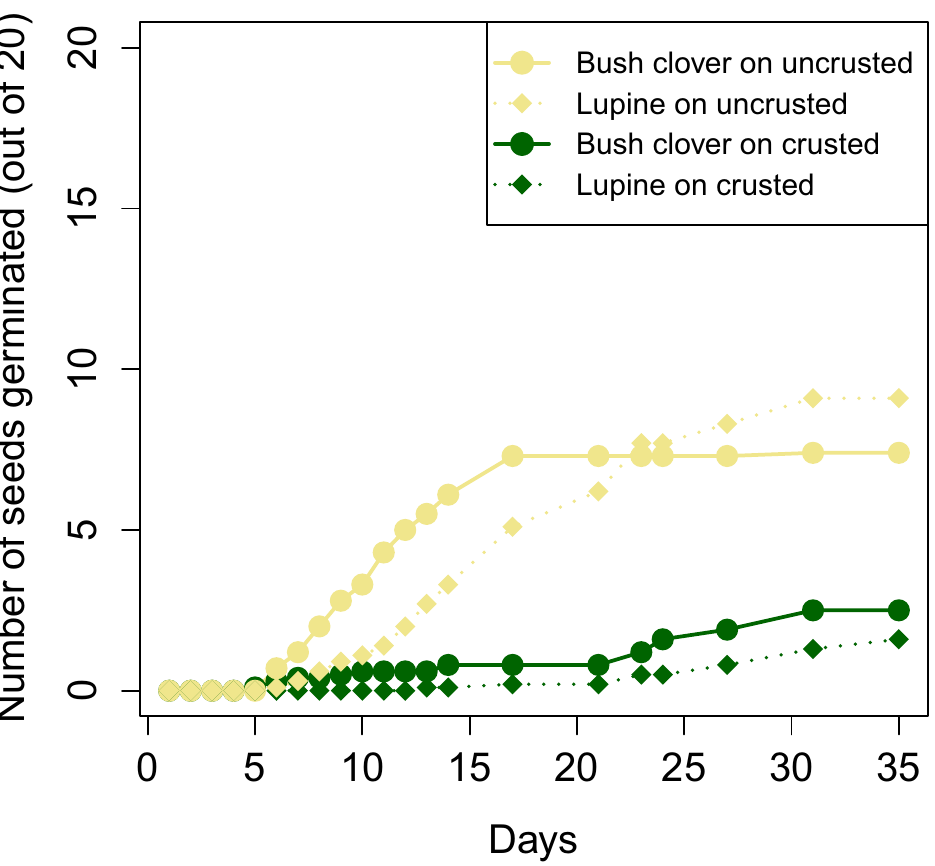
Fig 3. Cumulative number of germinated seeds for bush clover and lupine on each soil type during the 35-day experiment.